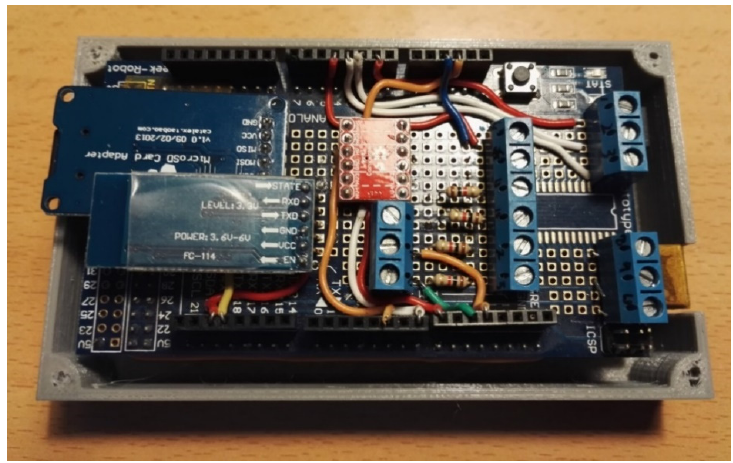
Figure 2. Mounting on the shield.